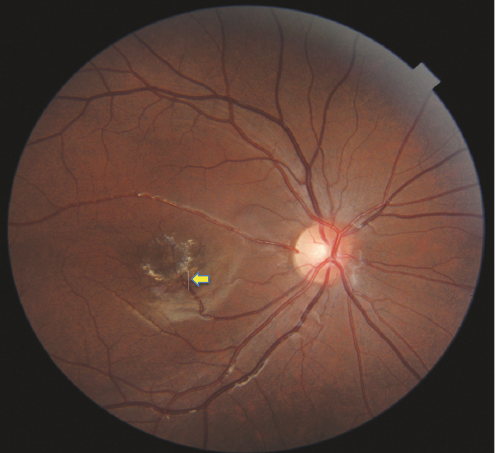
Figure 1: Right fundus photograph of a 12-year-old patient with a congenital retinal macrovessel (arrow) extending towards the fovea in a superotemporal course. The foveal reflex appears disturbed by the macrovessel.